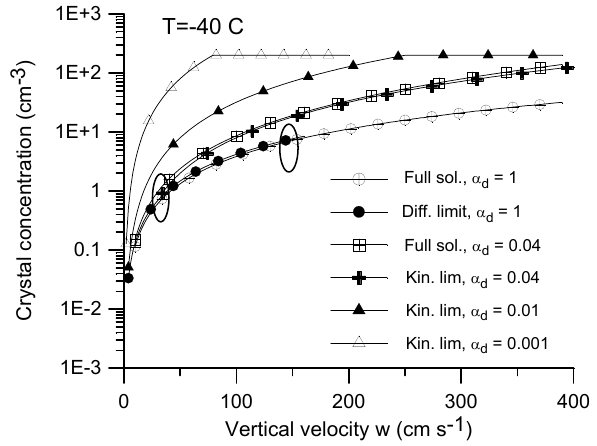
Fig. 10. Comparison of the full solution (81), (82) with Ψ defined in (74) at two values of α d = 1 and 0.04 (Full sol.) with diffusion limit (87) - (89) and kinetic limit (92) - (94). The diffusion approximation (solid circles) is valid at λ << 1, and limited here at w ≤ 170 cm s -1 ; the kinetic limit is valid at λ >>1 and with α d = 0.04 is limited here at w > 30 cm s -1 ; both limits are denoted with ellipses.